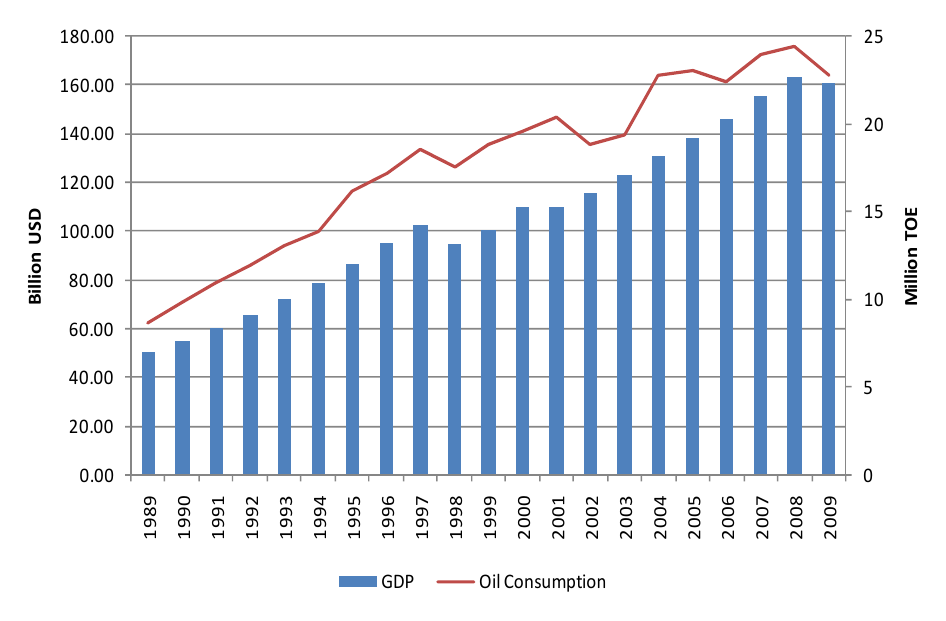
Figure 2. GDP and oil consumption (data source: